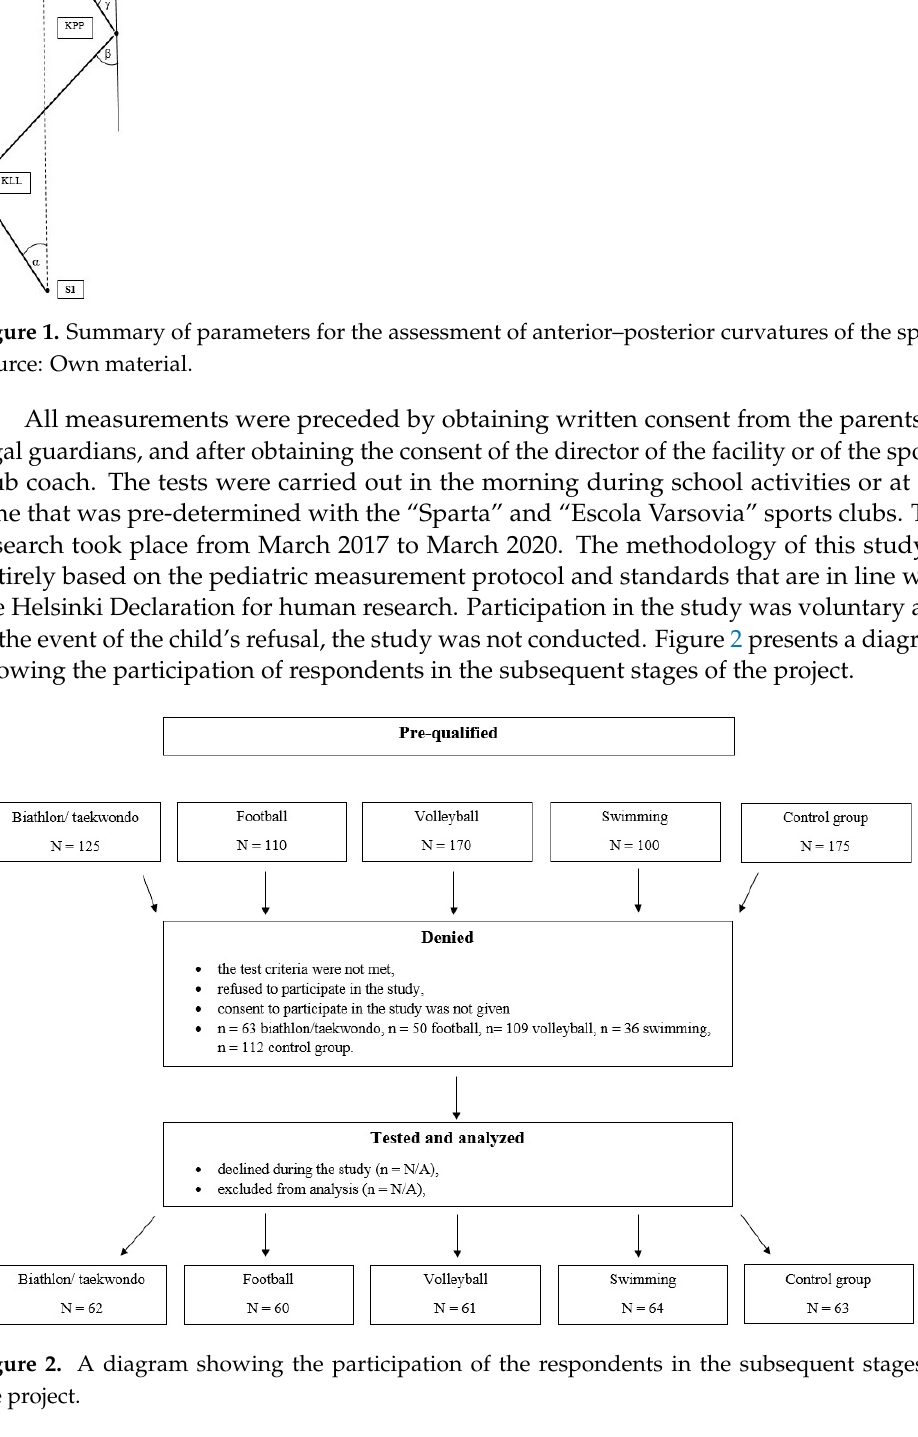
Figure 1. Summary of parameters for the assessment of anterior–posterior curvatures of the spine. Source: Own material .